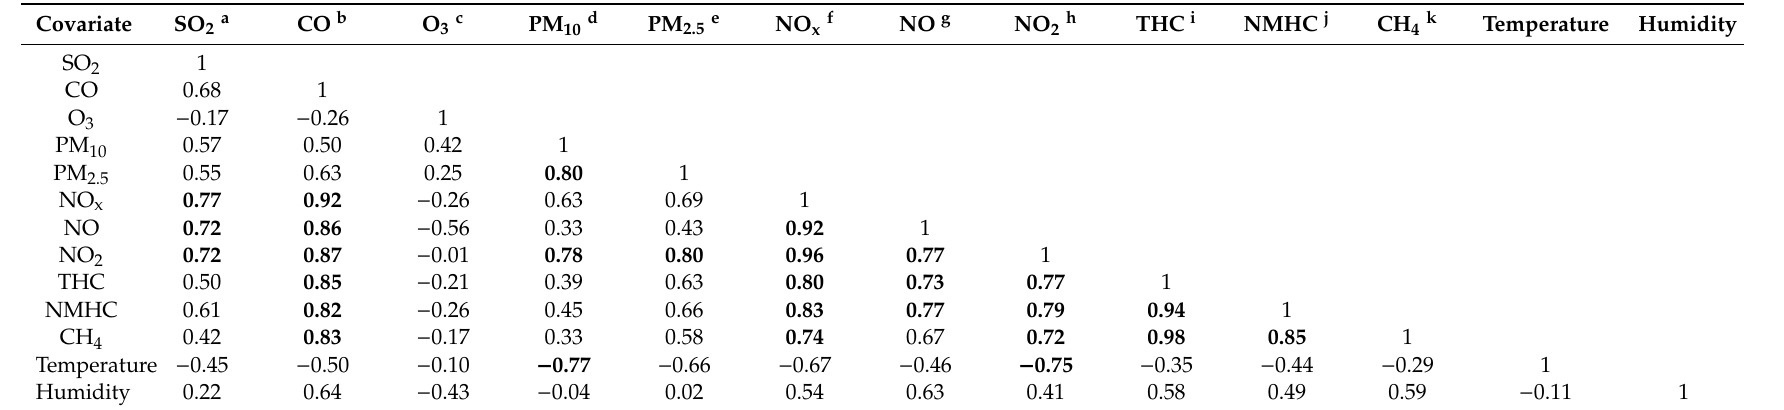
Table 1. Correlation coe ffi cients for air pollutants during the study